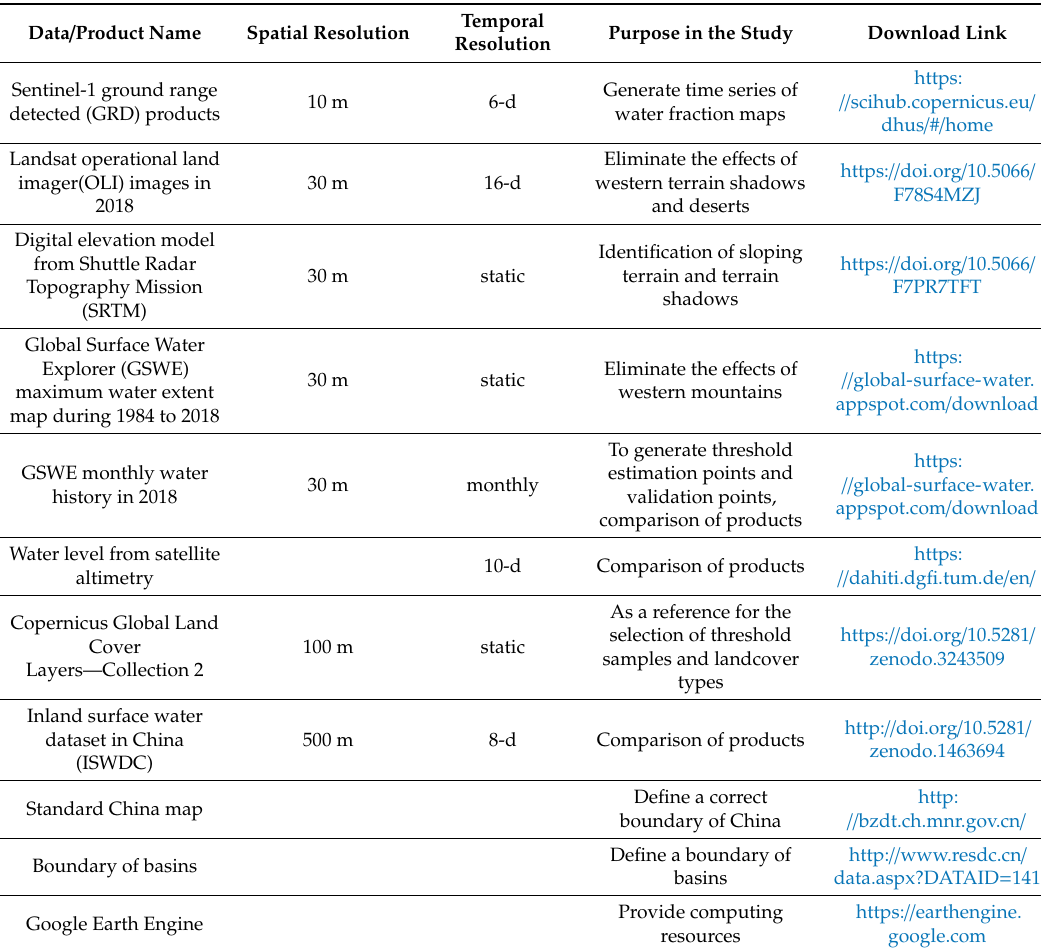
Figure 1. ( a ) Spatial distribution of Sentinel-1 observations in 2018 and ( b ) the number of images per month used for 2016, 2017, and 2018. The boundary layer of China is from National Administration of Surveying, Mapping, and Geoinformation of China: GS (2016)1569. Table 1. All datasets and tools used in this study.